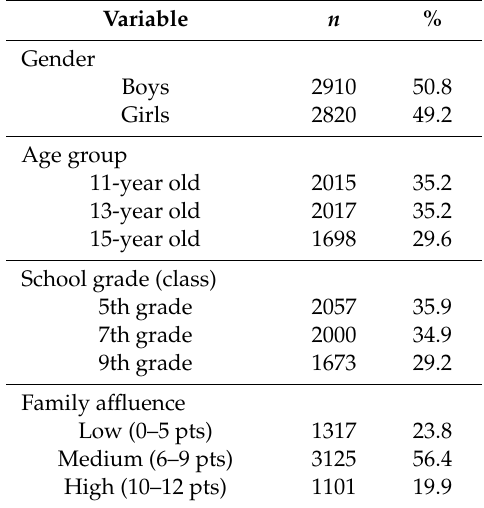
Table 1. Study sample by age, gender, school grade, and family a ffl